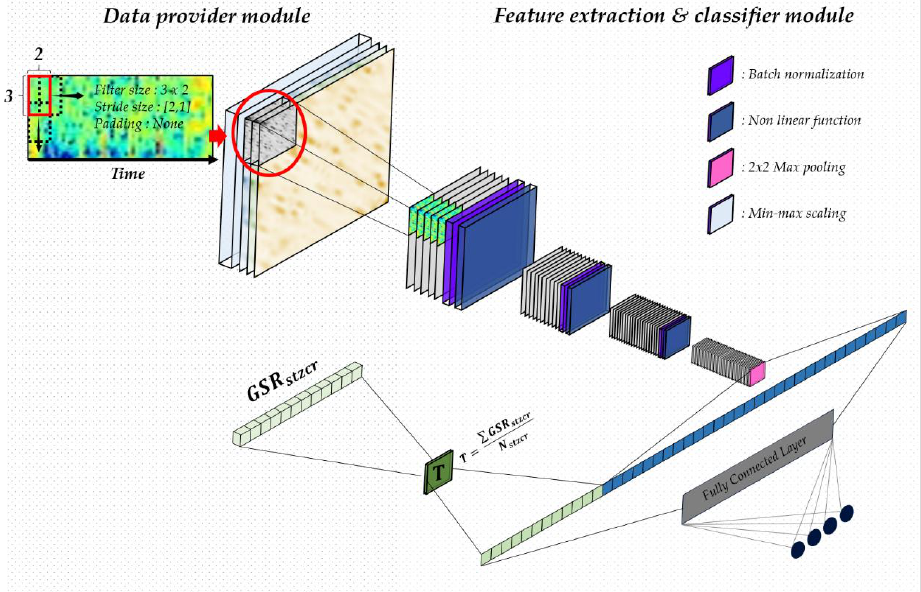
Figure 5. Proposed convolution neural network combining electroencephalogram (EEG) and wavelet transformed galvanic skin response (GSR).